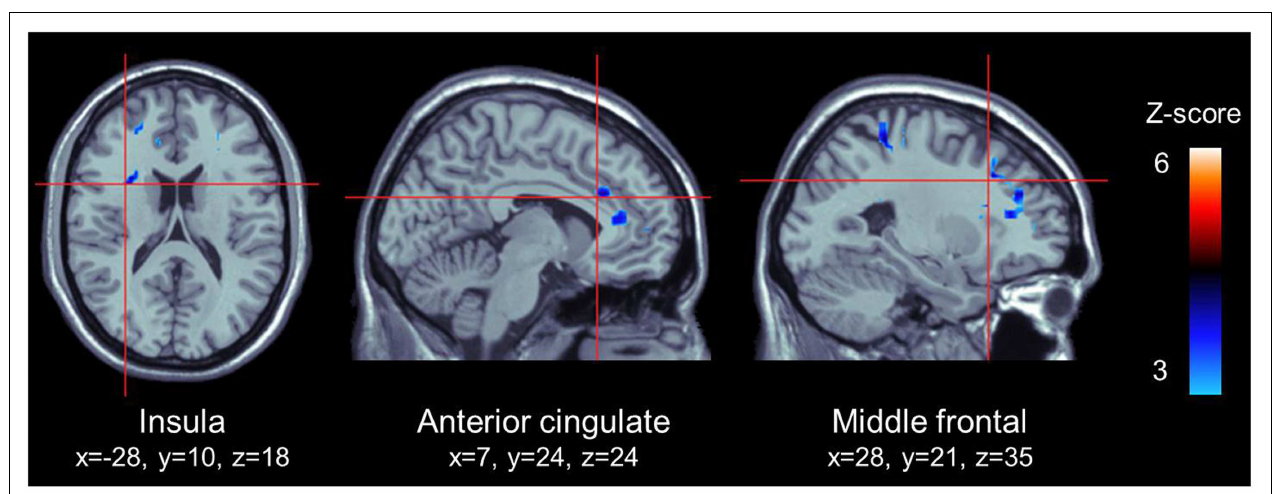
FIGURE 3 | ROI that presented a significant negative connectivity with the posterior cingulate cortex . All highlighted regions in this figure were significantly activated.Transition from blue to red color represents increases in z